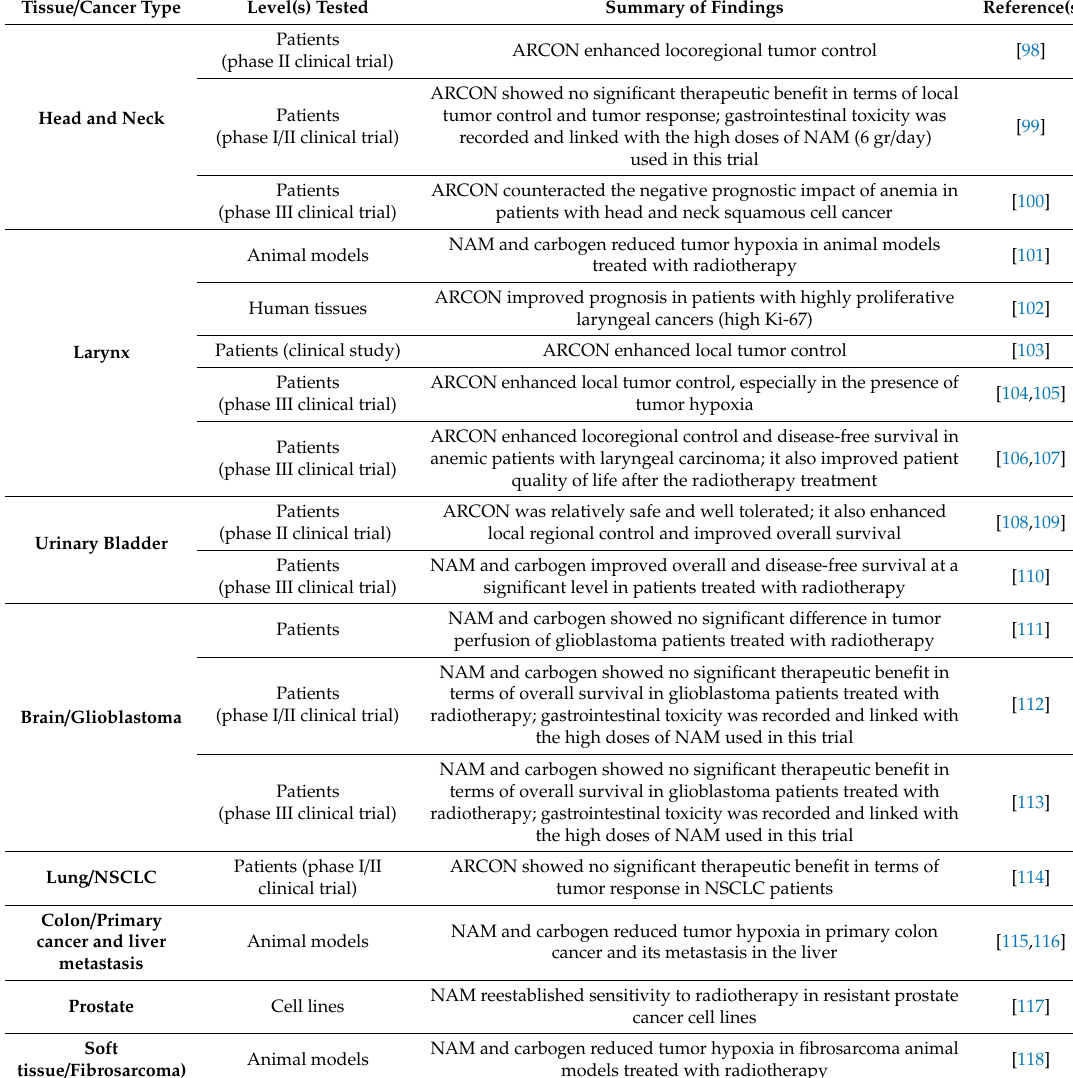
Table 2. Summary of evidence (preclinical / clinical) that supports the role of nicotinamide (NAM) in cancer